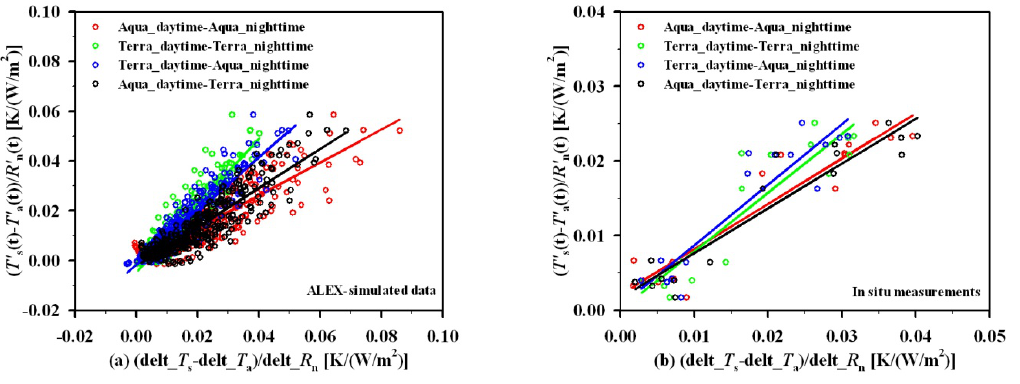
Table 1. Statistics of relationships between the values of ( T